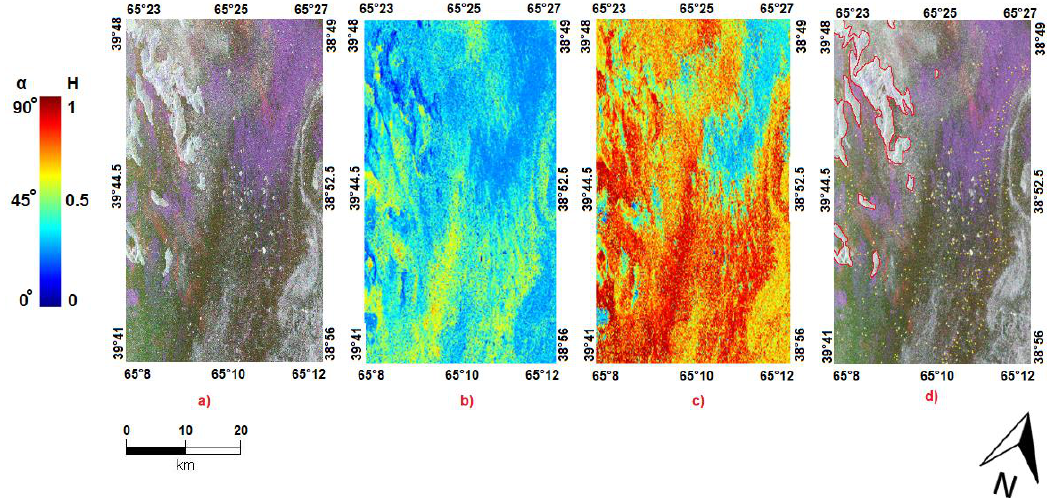
Figure 6. Output images for Isortoq, 03 / 08 / 2015 02:07, ( a ) Pauli RGB, ( b ) alpha image in a 5 × 5 window, ( c ) entropy image in a 5 × 5 window. ( d ) Pauli RGB visual analysis of icebergs. Yellow dots show icebergs. Red outline indicates coastline. Numbers on the edges of images indicate image DMS coordinates. The sea ice situation is a mix of open ocean (bluish area in the RGB) and small flows (grey areas).